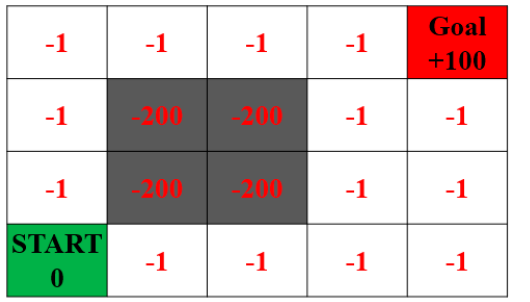
Figure 11. The schematic diagram of the reward and punishment rules.